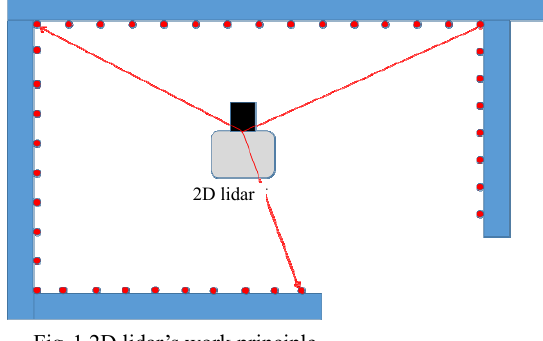
Fig. 1 2D lidar’s work